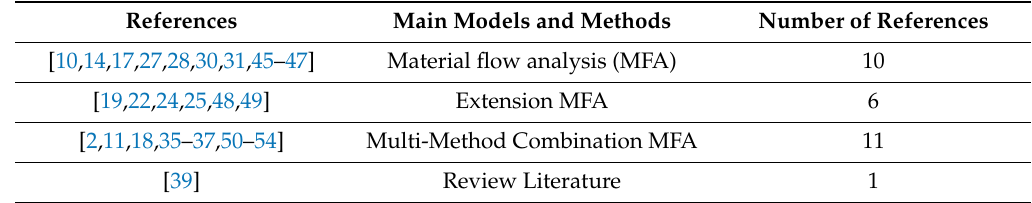
Table 1. 28 An overview of 28 articles classified according to their models and